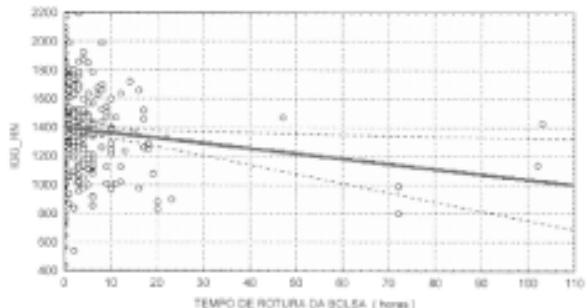
FIGURA 7 - Reta de regressªo e equa(cid:231)ªo correspondente da rela(cid:231)ªo IgG materna com IgM materna IGG_M(mg%)= 1109,7 + 0,44699*IGM_M(mg%) Correla(cid:231)ªo: